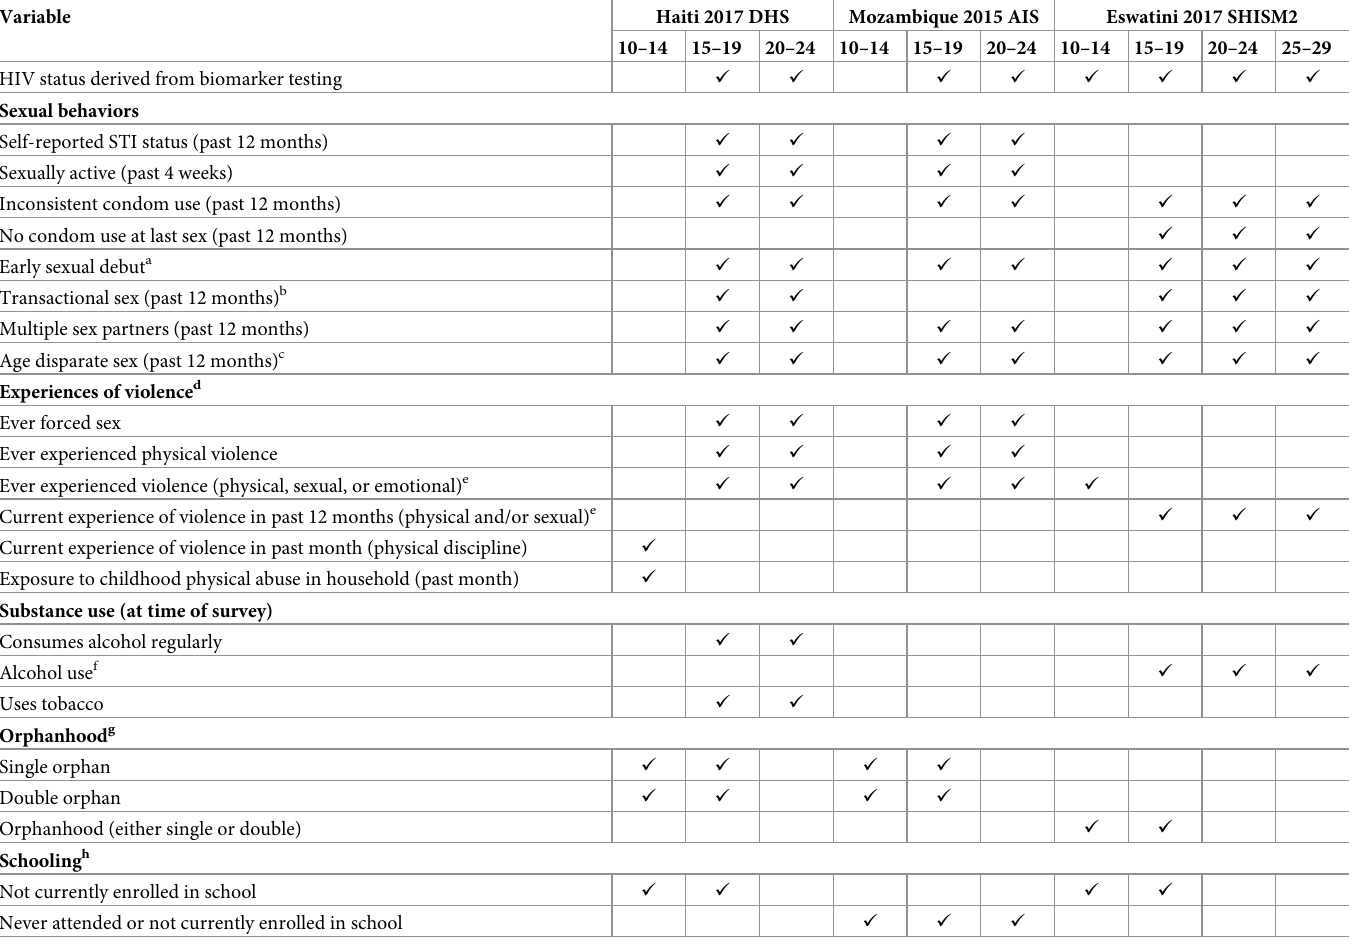
gram. A detailed description of variable construction is described in S1 Table. The study coun- tries tracked very few risk factors for the 10–14 age band. Table 1 summarizes the availability of data by survey and age band on the risk factors we analyzed in this study.